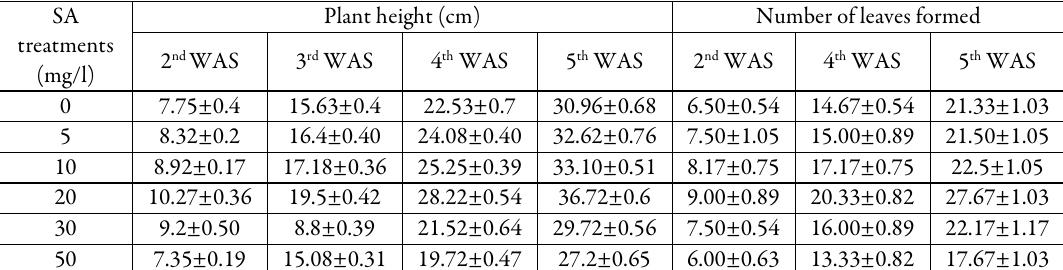
Table 2. Average seedling height and leaf number of C. cajan grown in soils with various concentrations of SA SA Plant height (cm) Number of leaves formed treatments 2 nd WAS 3 rd WAS 4 th WAS 5 th WAS 2 nd WAS 4 th WAS 5 th WAS (mg/l) 0 7.75±0.4